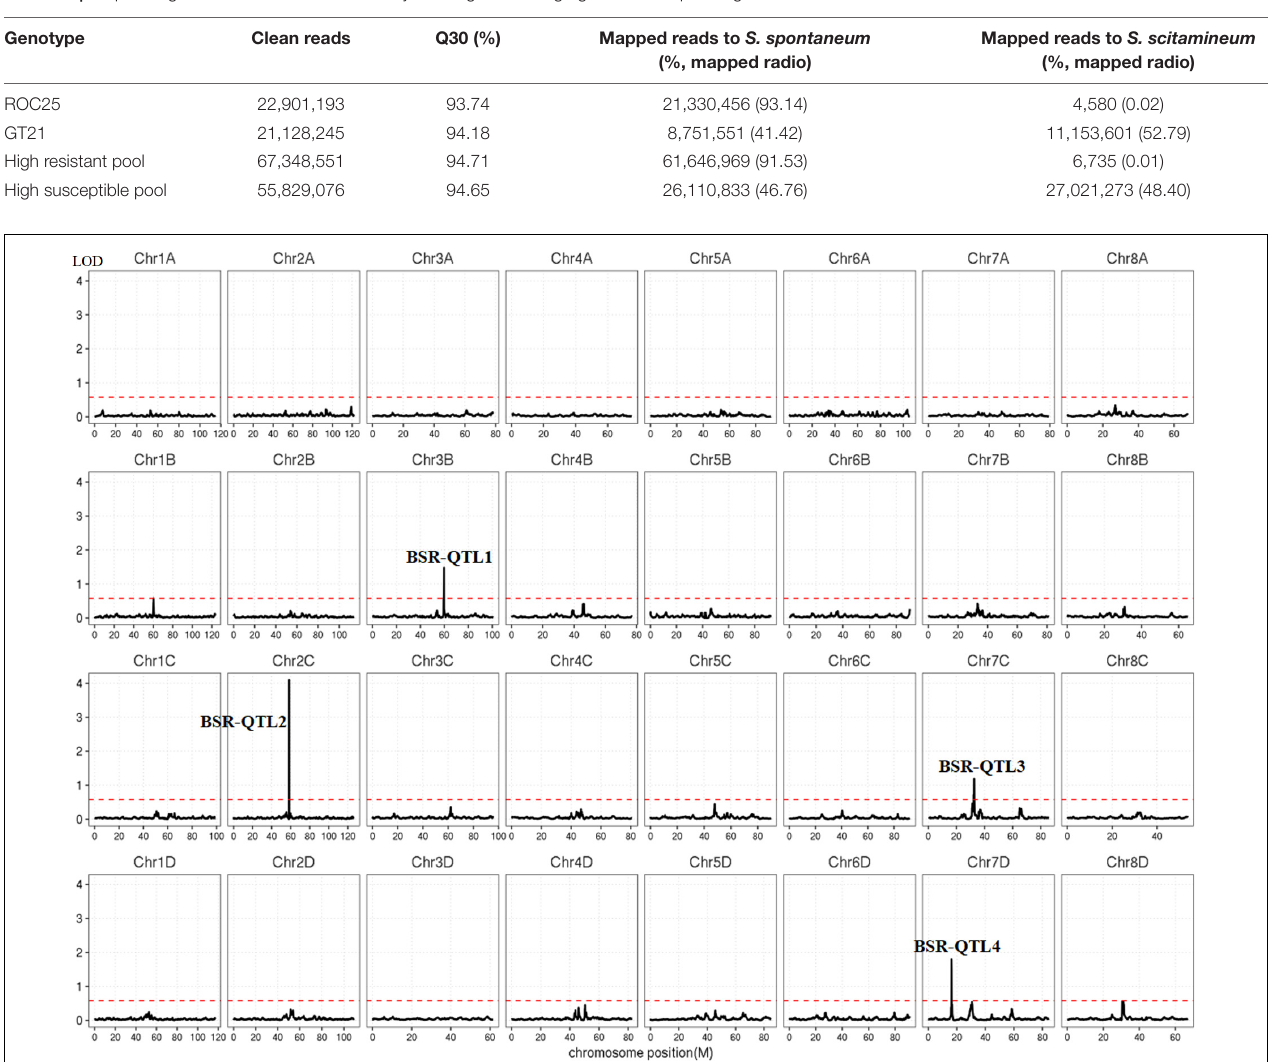
TABLE 5 | Sequencing reads for the association analysis using bulked segregant RNA sequencing.